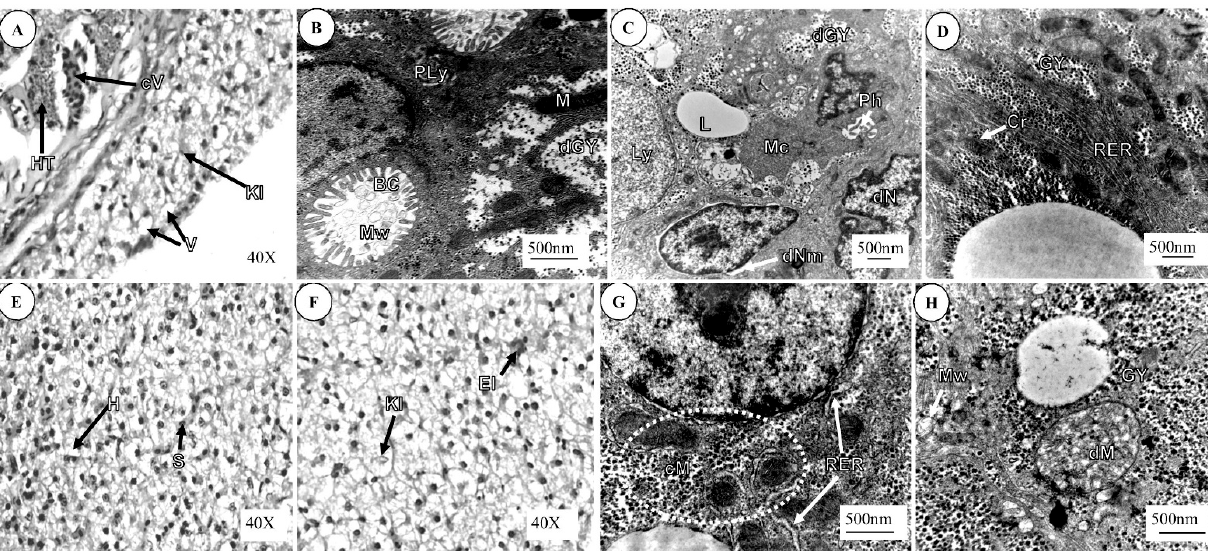
Figure 3. Alterations in hepato-architecture of C. carpio after exposure to malachite green and E. officinalis for 30 days. MG: ( A ) (40 × )—Liver with nuclear alteration such as karyolysis (KL), hypertrophied cells (HT) and congested vessel (cV) and cytoplasmic vacuolation (V). ( B ): Bile canaliculi displayed decreased Microvilli (Mi) count and abundant membrane whorls, phagolysosomes (PLy) digesting various organelles, scarcity of glycogen content (dGY) and mitochondria (M). ( C ): Lipid deposits (L), lysosomes (Ly), macrophage (Mc), phagosomes (Ph), deformed nucleus (dN) and its membrane (dNm) in hepatocytes. E. officinalis alone: ( D ): regular hepato-architecture, mitochondrion with cristae (Cr), glycogen (GY) and large number of RER strands. ( E ) (40×)—Hepatocytes (H) with interspersed sinusoids (S). MG + E. officinalis : ( F ) (40×)—Karyolysis (Kl) and erythrocyte infiltration (EI). ( G ): Clumped mitochondria (cM), proliferated RER. ( H ): Dissolving mitochondrion cristae (dM), membrane whorls (Mw) in space of Disse and restored glycogen content (GY). Light microscopy revealed conspicuous deformities in the nucleus, along with the presence of a large number of cytoplasmic vacuolation and necrotic bodies in hepatocytes after 60 days of MG treatment (Figure 4A,B). At cellular level, extensive vacuolization and diminished glycogen content occurred in hepatocytes. Cellular organelles underwent